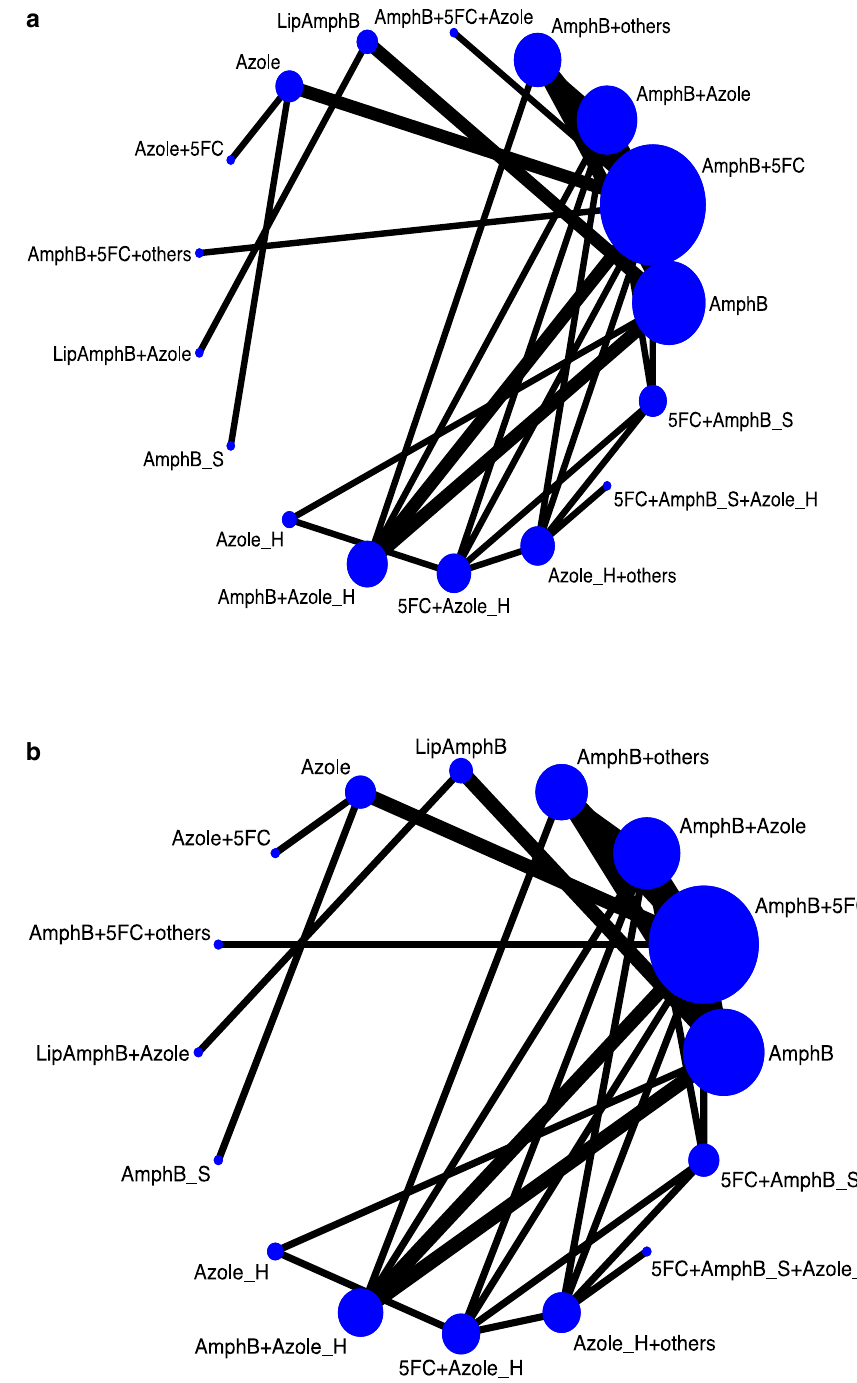
Figure 2. Network structure of network meta-analysis of different outcomes for cryptococcal meningitis in HIV patients. ( a ) Network structure of network meta-analysis of early mortality rate for cryptococcal meningitis in HIV patients. ( b ) Network structure of network meta-analysis of late mortality rate for cryptococcal meningitis in HIV